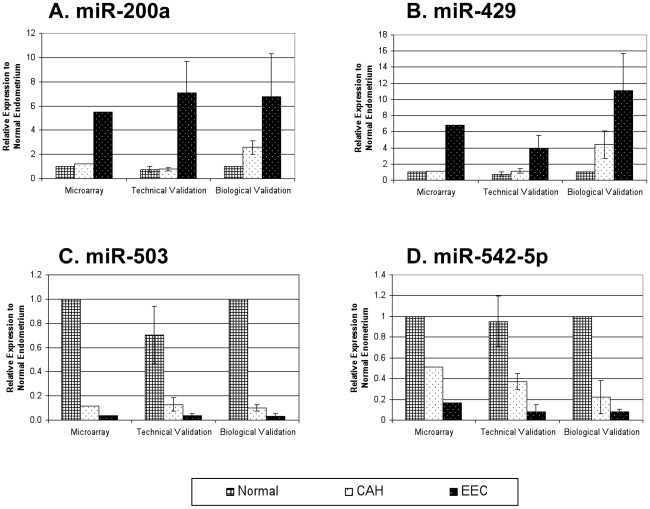
Quantitative RT-PCR results.Validation RT-PCR was performed using formalin-fixed paraffin embedded tissues from the original sample set as well as a new sample set using primers for miR-200a (A), miR-429 (B), miR-503 (C), and miR-542-5p (D). Error bars represent standard deviation.